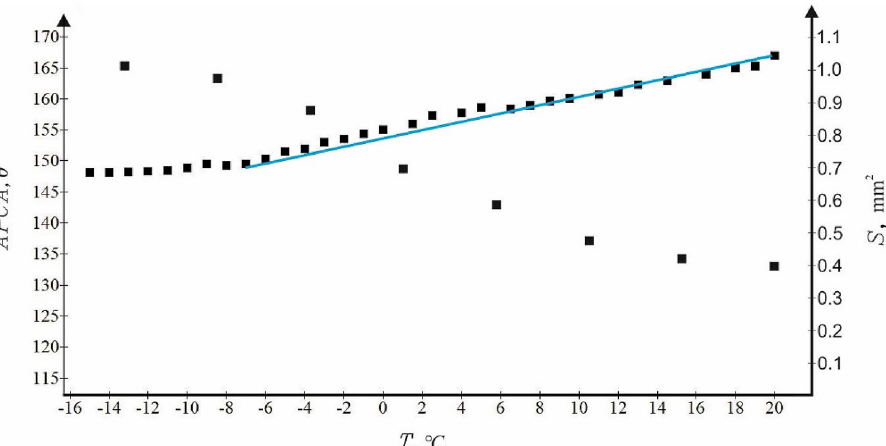
Figure 9. Dependences of APCA (θ) and the contact area ( S ) on the temperature of the supporting surface are depicted. The blue straight line illustrates the linear approximation of the temperature dependence of APCA d θ ∼ = 10 − 2 rad in the range − 6 °C < t < 22 °C; dT K . The contact area S is stabilized at t completion of ice crystallization at the contact area.